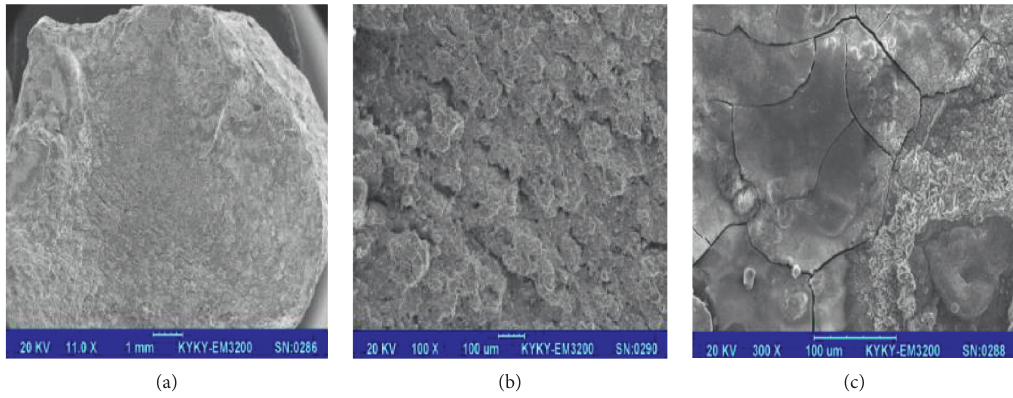
Figure 14: Steel fatigue failure surfaces of Beam 5. (a) Source zone. (b) Development zone. (c) Fracture